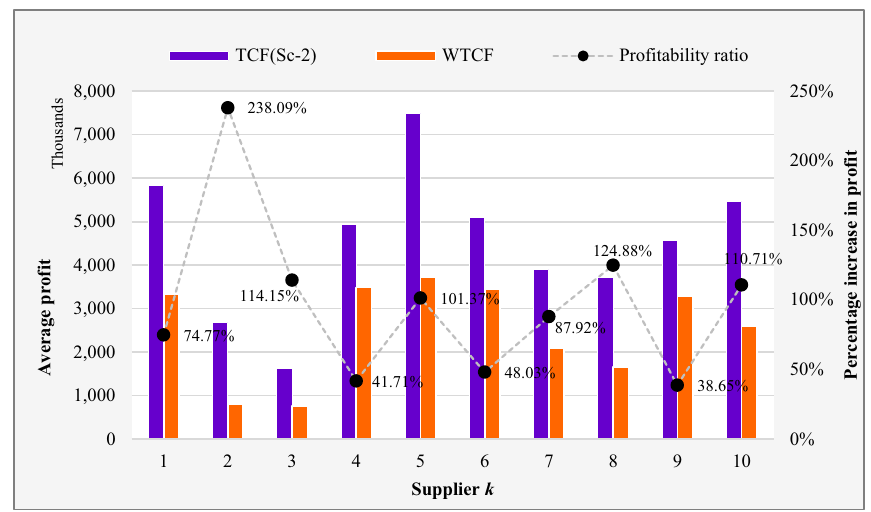
Fig. 9 the effects of TCF contract in Sc-2 on the supplier’s profit for test problems of size 2